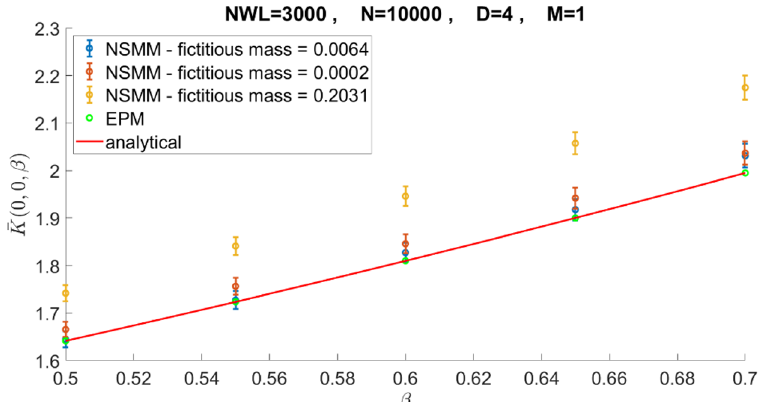
Figure 4 . Calculations of the heat kernel for the free scalar particle on the sphere with ( N WL , N ) = (3000 , 10000) and or different values of the fictitious